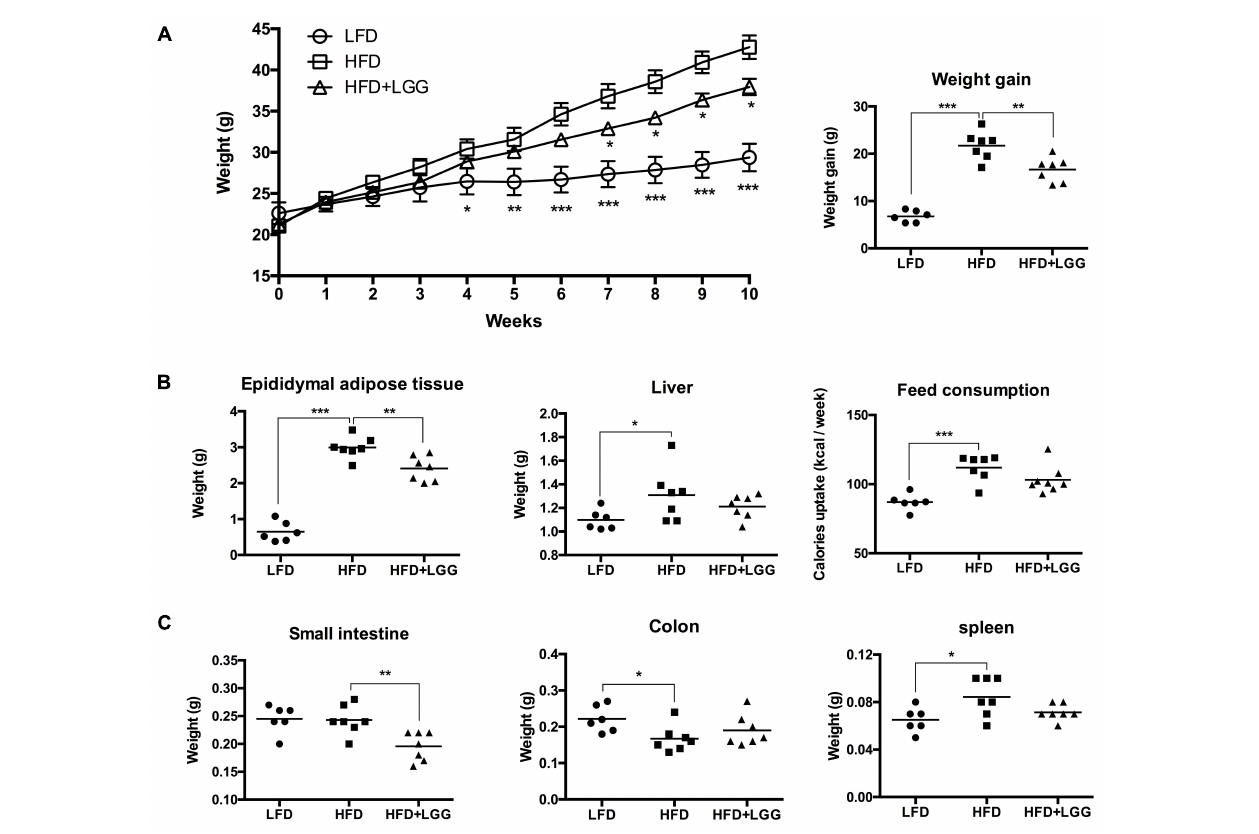
FIGURE 1 | Impact on body and organ weight by HFD and LGG in a DIO murine model, showing (A) weekly weight changes and total weight gain. (B) EAT, liver and feed consumption. (C) Small intestine, colon and spleen weight. Significance level was calculated using ANOVA and Bonferroni’s multiple comparisons test. Results are illustrated as ∗ p < 0.05, ∗∗ p < 0.01, ∗∗∗ p <